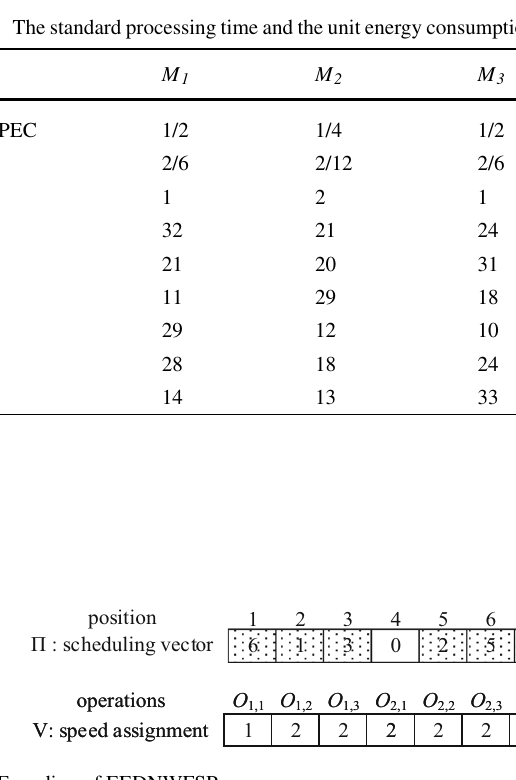
Fig. 4 Encoding of